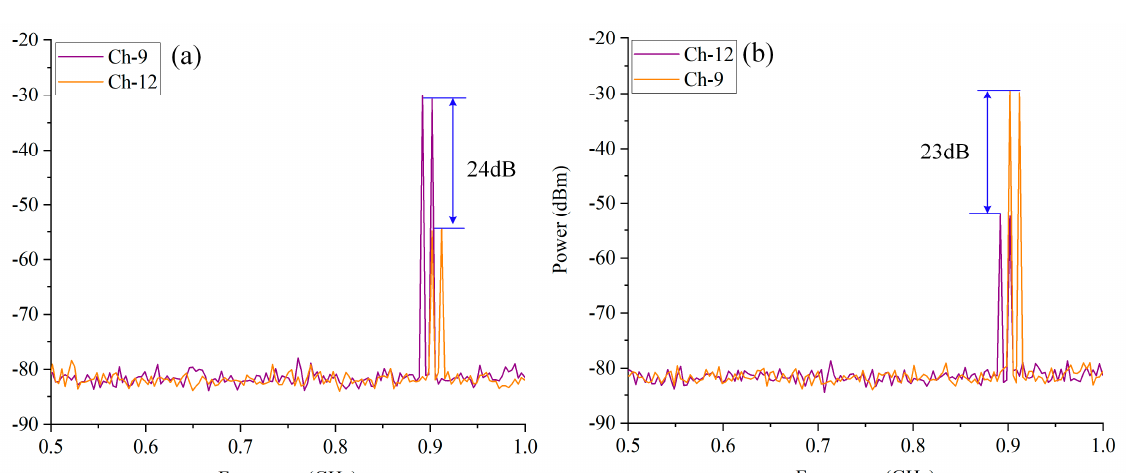
Figure 6. Electrical spectra of ( a ) Ch − 9 as the desired channel and ( b ) Ch − 12 as the desired channel.